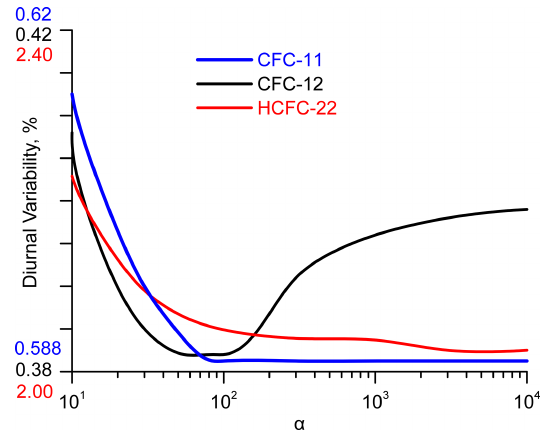
Figure 3. Dependence of the TCs intraday variability in the regu- larization parameter α